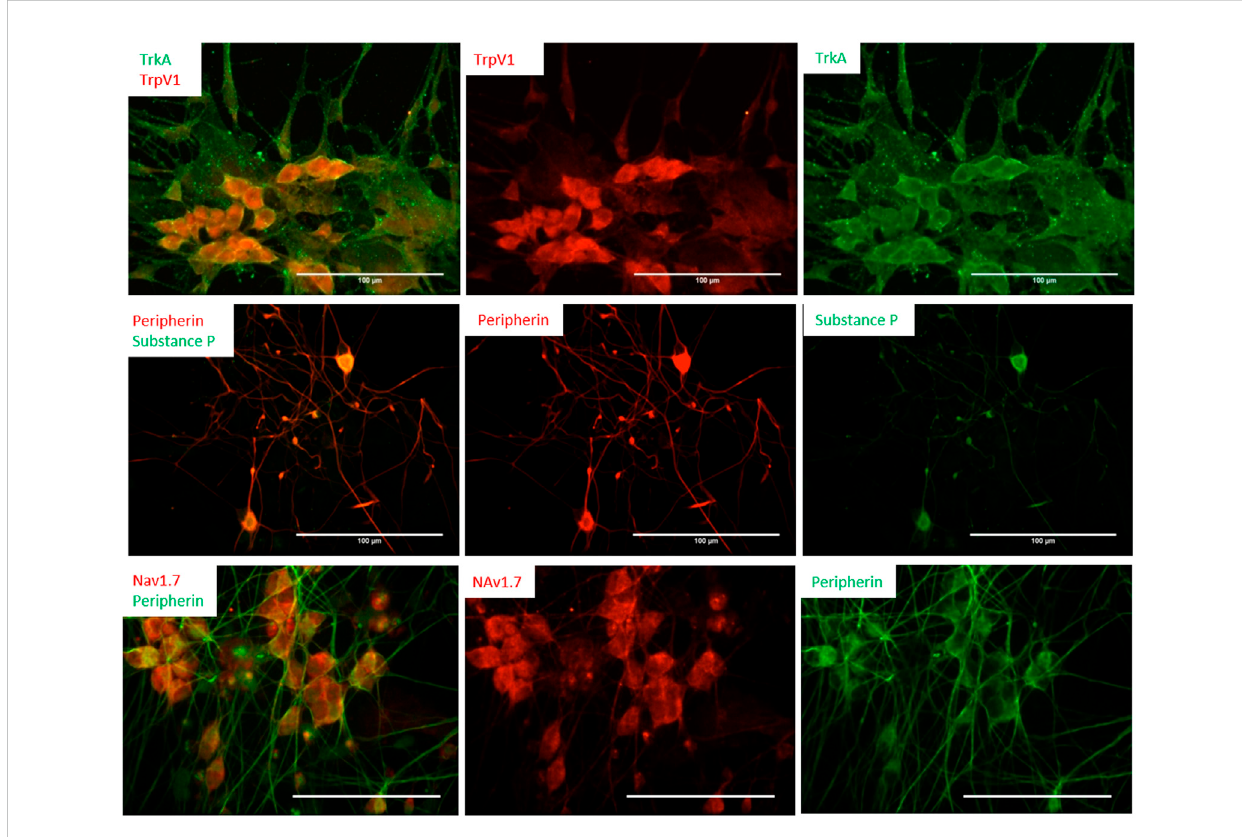
FIGURE 2 Differentiation of nociceptors from human iPSCswas characterized by immunocytochemistry. The cells wereimmunostained for the expression of NGF and the VR1 receptors TrkA and TrpV1 (Day 14, top panel), as well as the neuropeptides Substance P (Day 16, middle panel) and Nav1.7 (D21, bottom panel). Scale bar: 100 μ